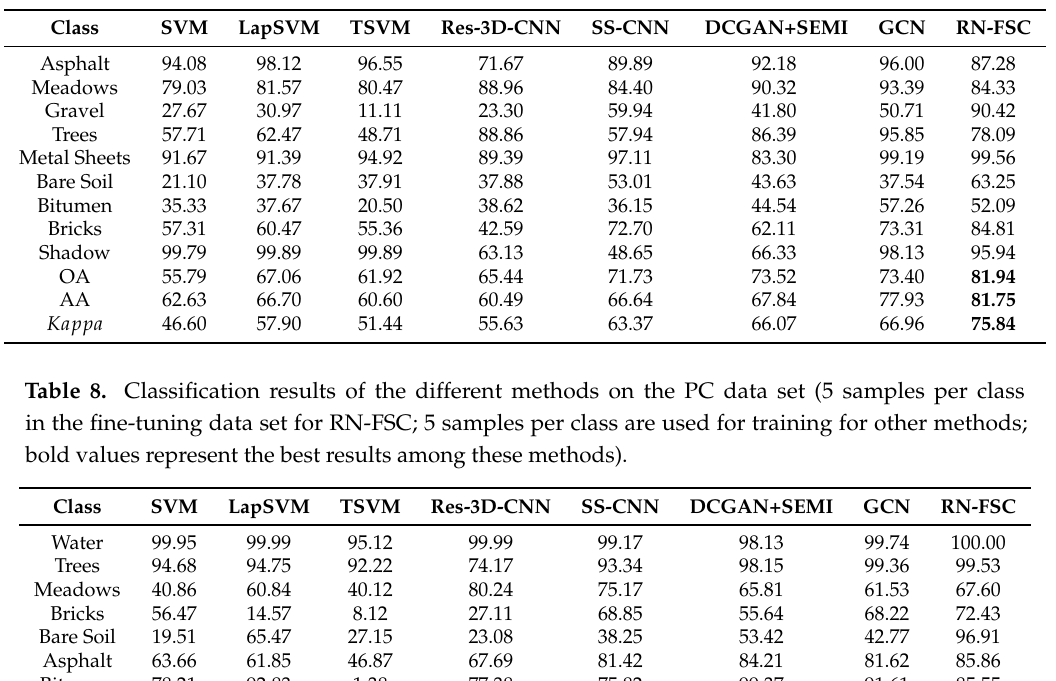
Table 7. Classification results of the different methods on the UP data set (5 samples per class in the fine-tuning data set for RN-FSC; 5 samples per class are used for training for other methods; bold values represent the best results among these methods).